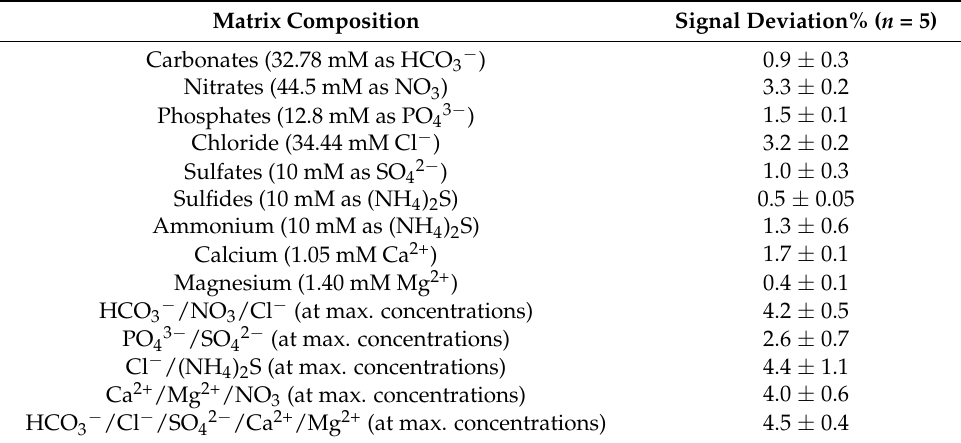
Table 4. Results obtained from the response of the phenol sensor to simulated water samples containing possible interference species and 6.2 pg/mL